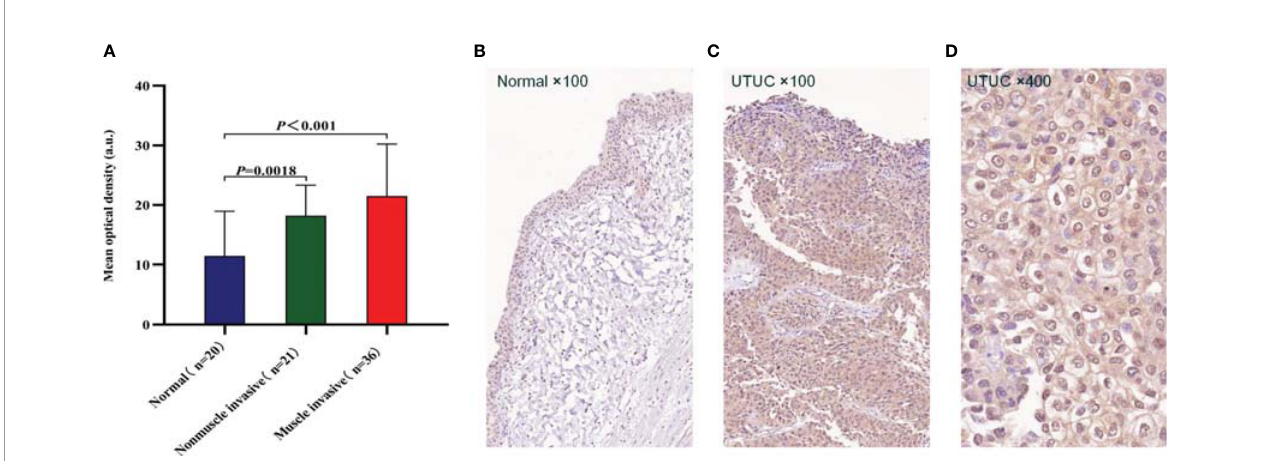
FIGURE 2 | Immunohistochemistry (IHC) for CD47 protein expression and distribution. (A) Qualitative analysis of IHC results revealed that CD47 protein expression was higher in both non-muscle-invasive (n = 21) and muscle-invasive (n = 36) upper urinary tract urothelial carcinomas (UTUCs) than that in normal uroepithelium (n = 20) ( P < 0.01), and P -values were determined using unpaired t tests. (B) CD47 was expressed in trace amounts in normal uroepithelium. (C) CD47 was highly expressed in UTUC tissues, CD47-positive cells were widely distributed in the cancer tissue, including on the luminal surface. (D) The localization of CD47 protein was mainly the tumor cell